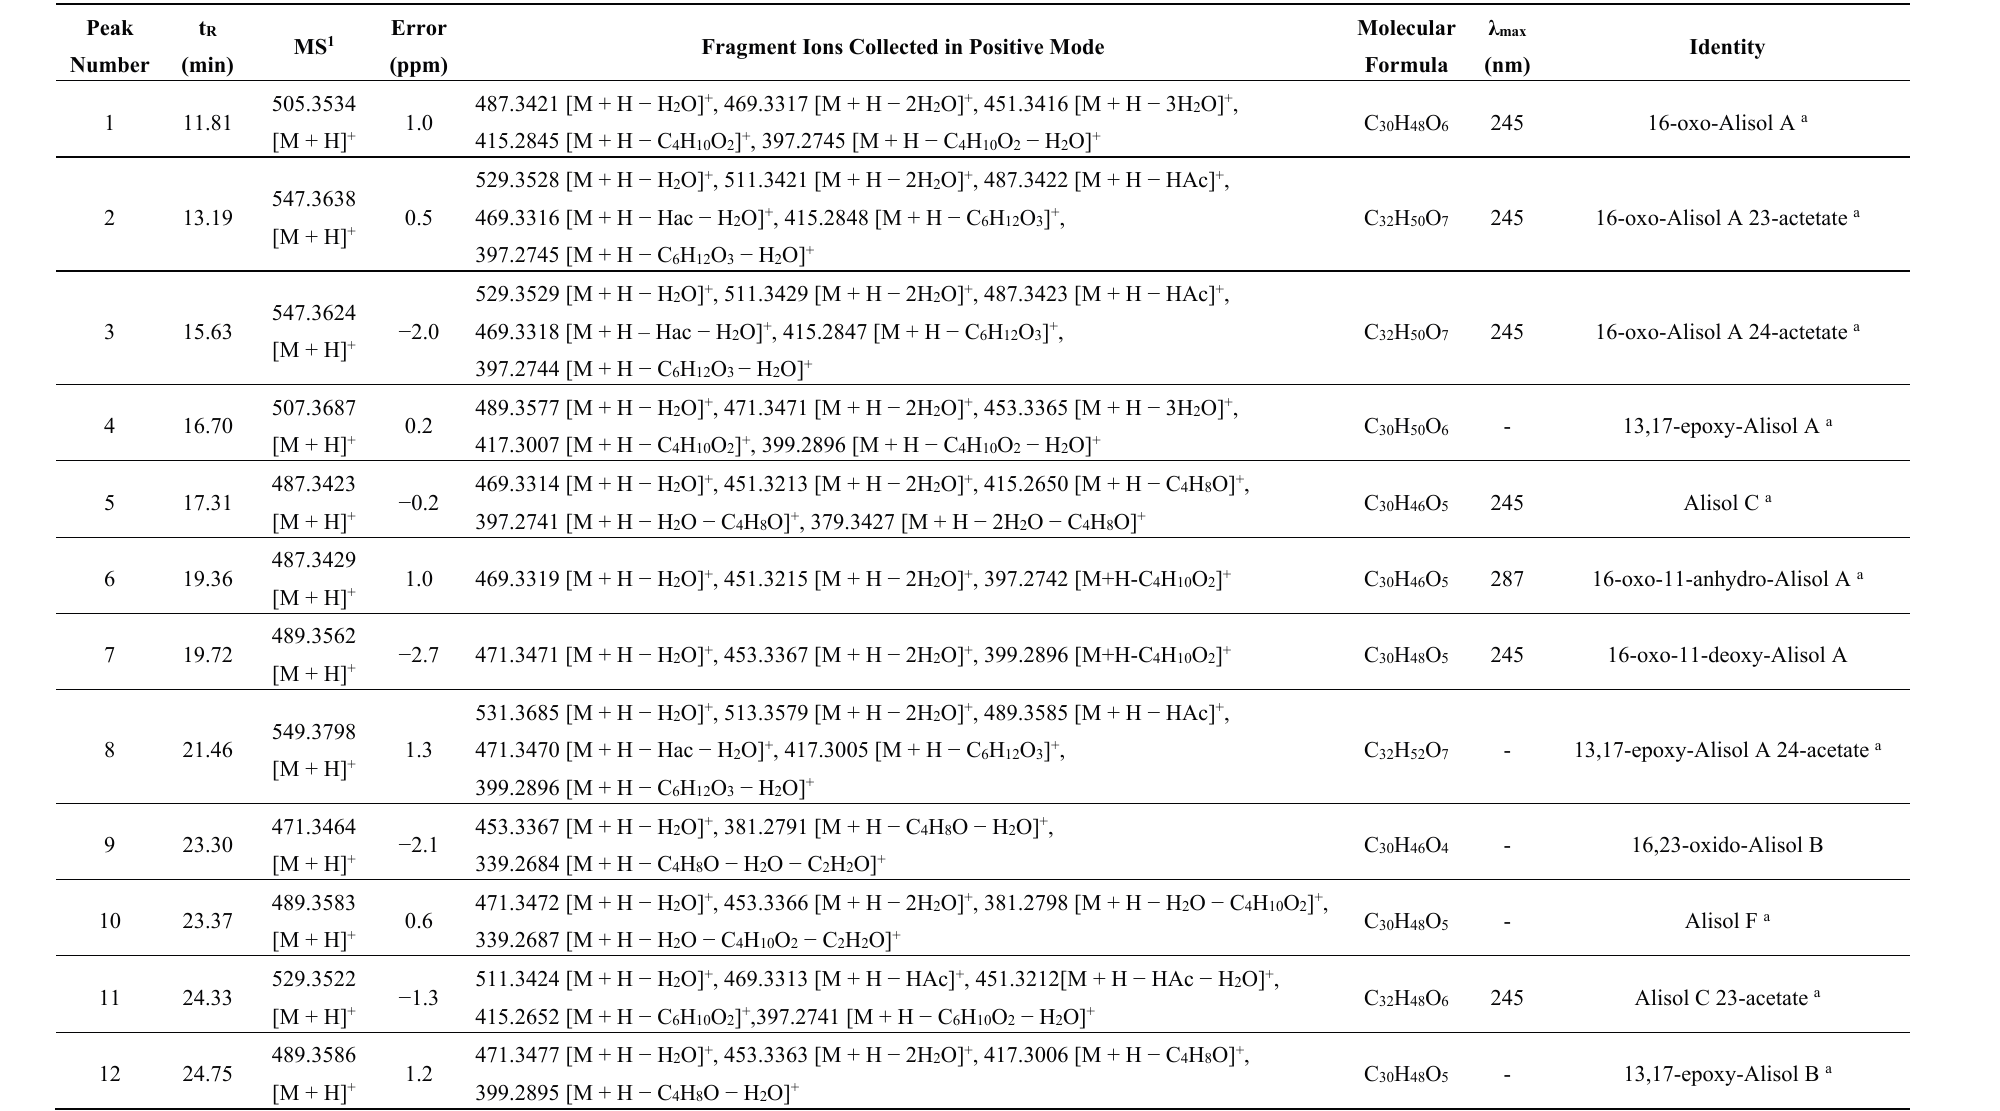
Table 2. Characterization of chemical constituents in AMR by HPLC-DAD-Q-TOF